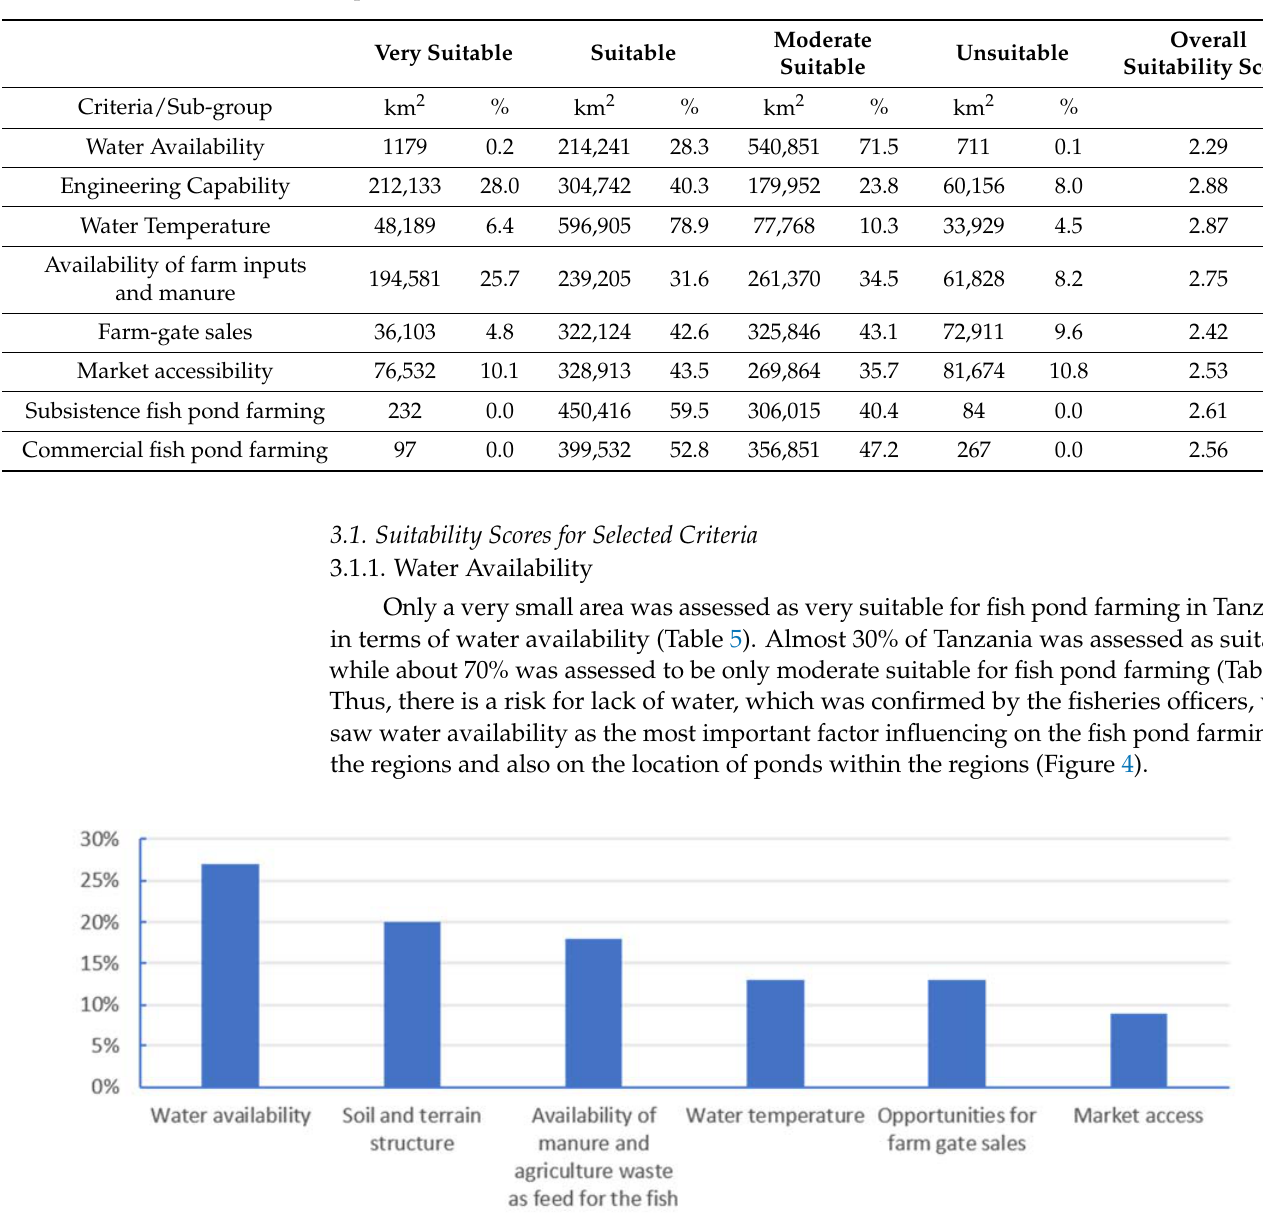
( b ) Figure 5. The distribution of suitability scores for; ( a ) annual water availability and ( b ) water temperature.